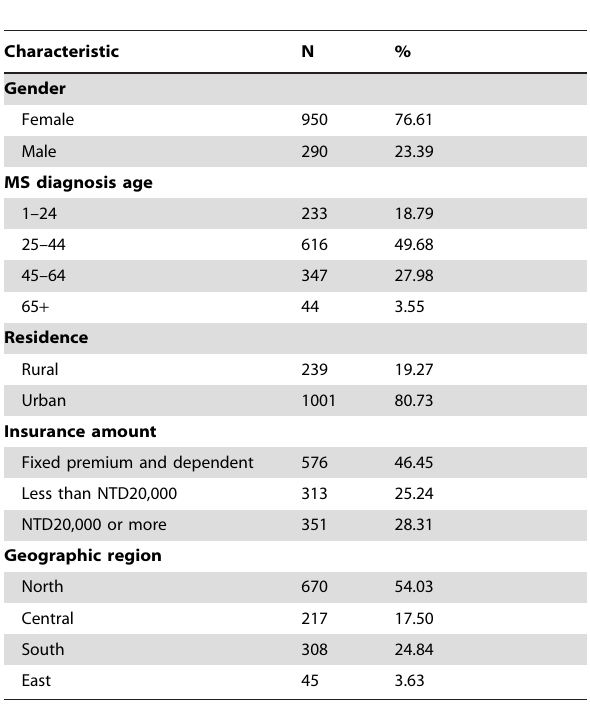
Table 1. Characteristics of 1,240 MS individuals in Taiwan, 1997–2008.